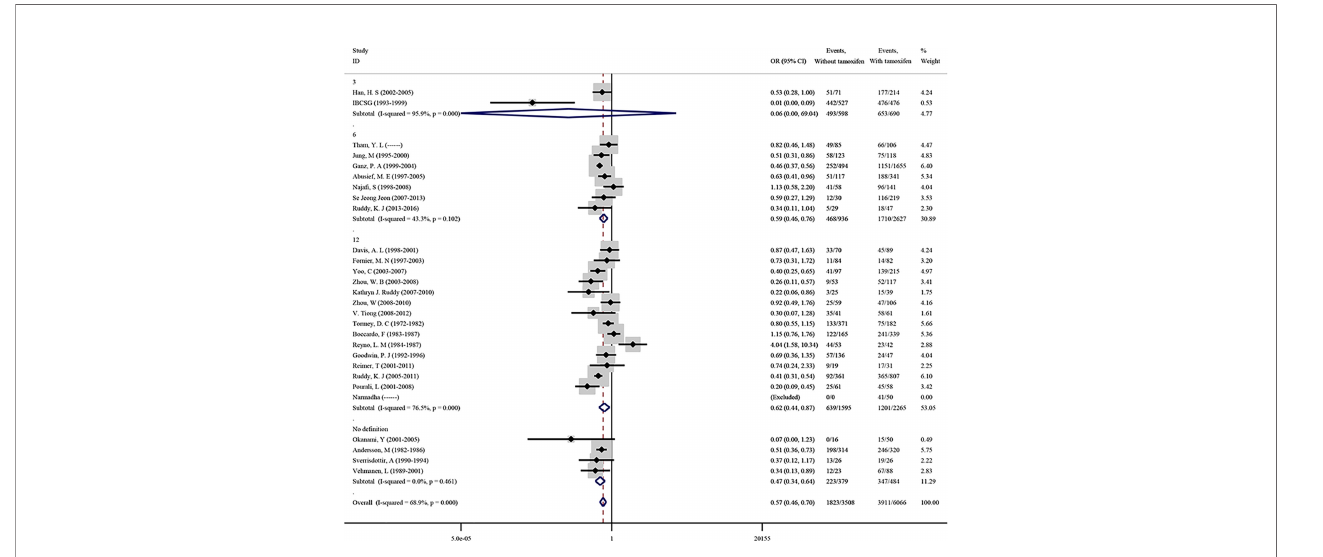
FIGURE 3 | Premenopausal breast cancer patients with or without the administration of tamoxifen on the incidence of